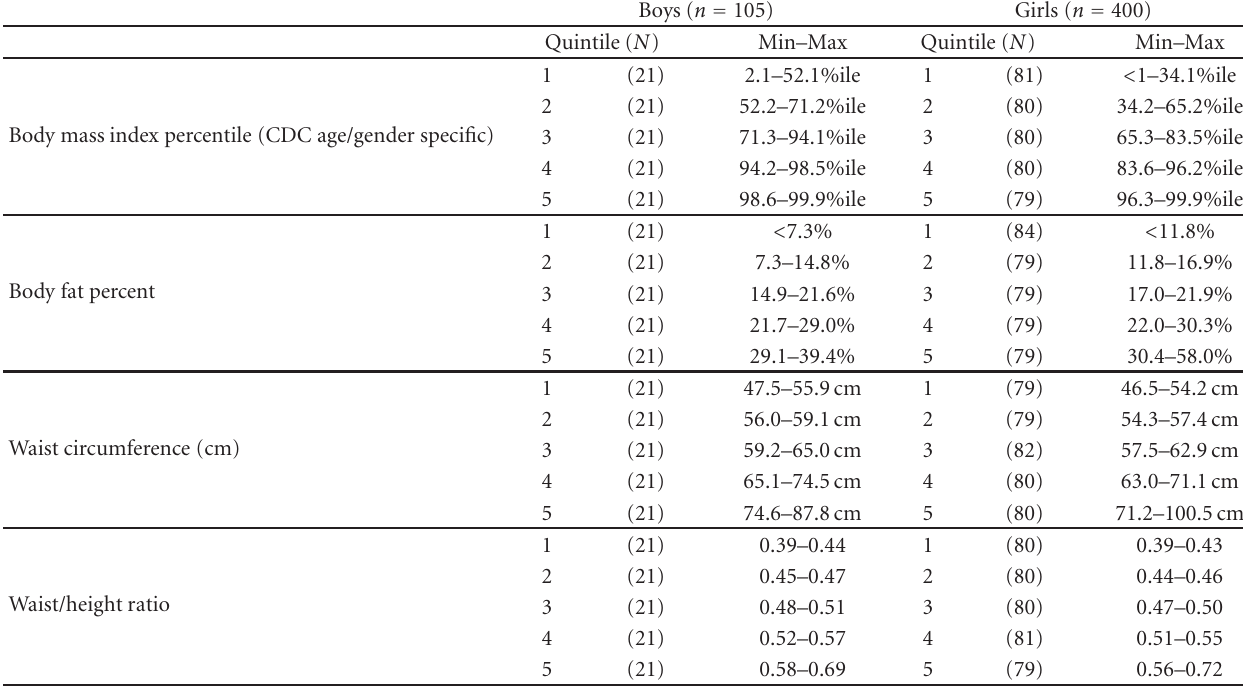
Table 4: Body fat measure quintile cutpoints in black and Hispanic boys and girls aged 6-to-8 years.